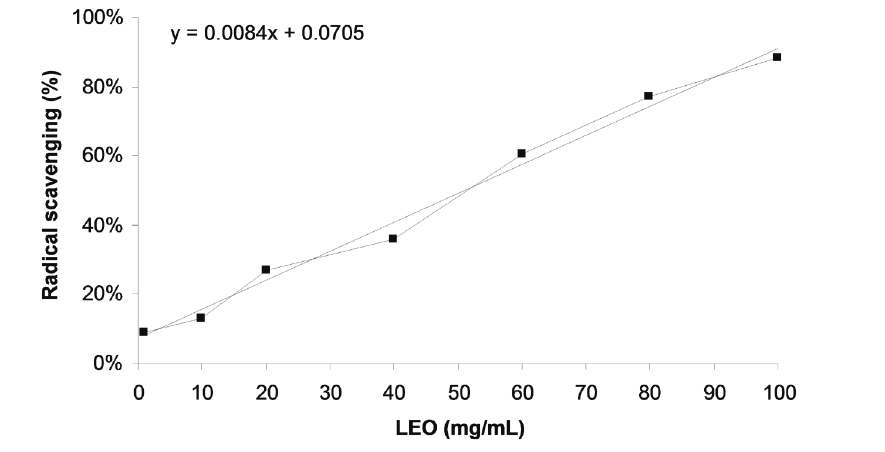
Figure 1 - Linear regression of radical scavenging effect of lavender essential oil (LEO) concentration on 2,2-diphenyl-1-picrylhydrazyl radical